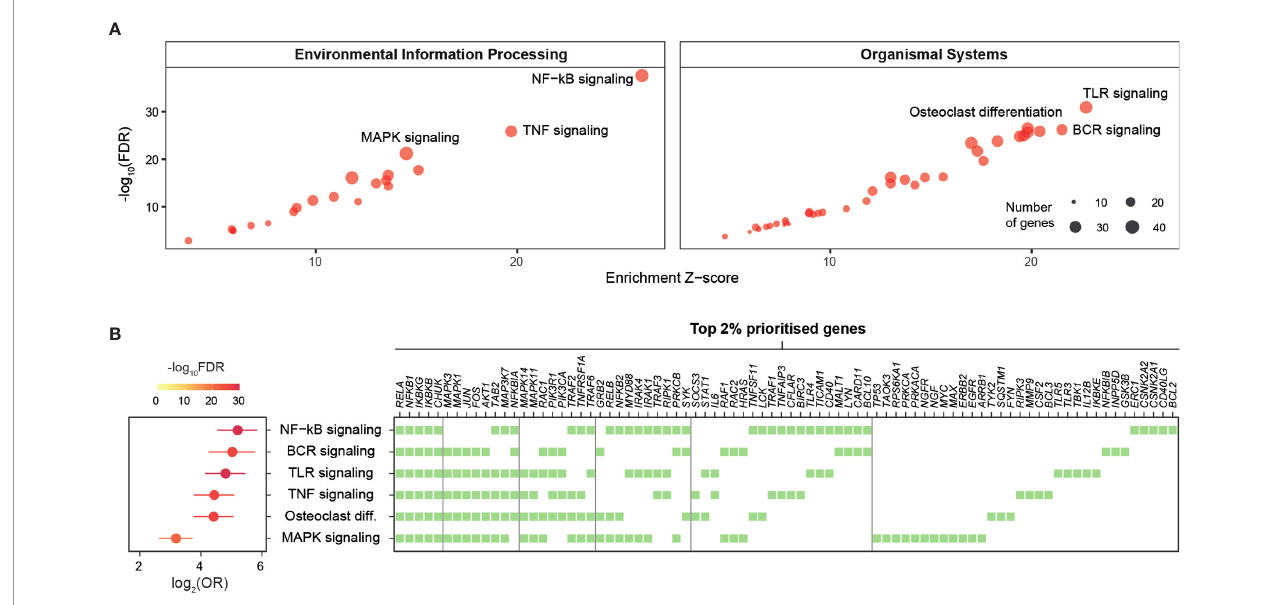
FIGURE 2 | Prioritization of target pathways in kidney stone disease. Pathway-level prioritization was based on enrichment analysis of the top 2% prioritized genes using a collection of KEGG pathways, with the enrichment Z-score, the signi fi cance level (FDR), odds ratio (OR), and 95% con fi dence intervals estimated according to Fisher ’ s exact test (one-sided). BCR, B-cell receptor; MAPK, mitogen-activated protein kinase; TLR, toll-like receptor; TNF, tumor necrosis factor. (A) Scatter plots illustrating prioritized pathways, with the top 3 displayed separately for environmental information processing pathways (left) and organismal systems pathways (right). Each dot represents an individual pathway and is sized by the number of member genes thereof. (B) Forest plots of the top 6 prioritized pathways (left), with member genes illustrated using a heatmap (right) in which genes are shown at the top and ordered by frequency of occurrence (colored